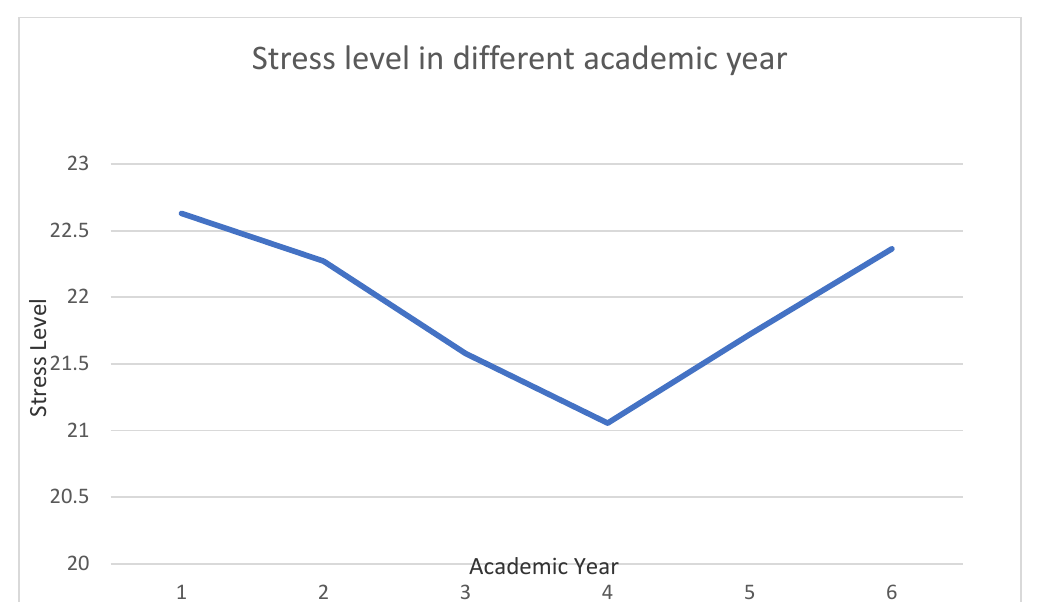
Figure 1. Shows the stress levels of medical students each year. First-year students are more stressed than other students ( p < 0.05). Stress decreases each year except for the internship students (sixth-year medical students), where stress significantly increases ( p < 0.05) .